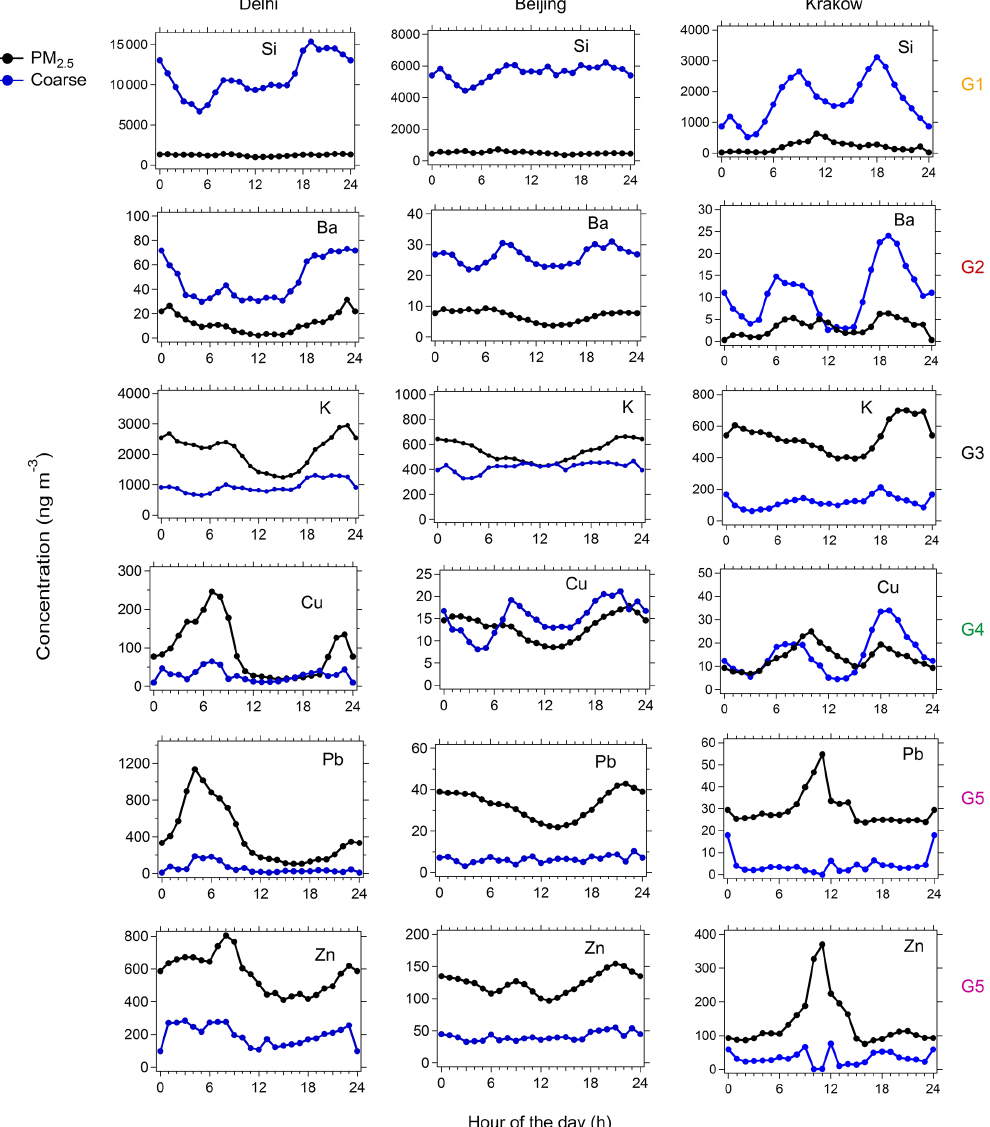
Figure 5. Diurnal variations of elements representative of each group (G1: Group 1, G2: Group 2, G3: Group 3, G4: Group 4, G5: Group 5) in PM 2 . 5 and coarse size fractions (PM 10 − PM 2 . 5 ) at Delhi, Beijing, and Krakow (see Fig. S8 for